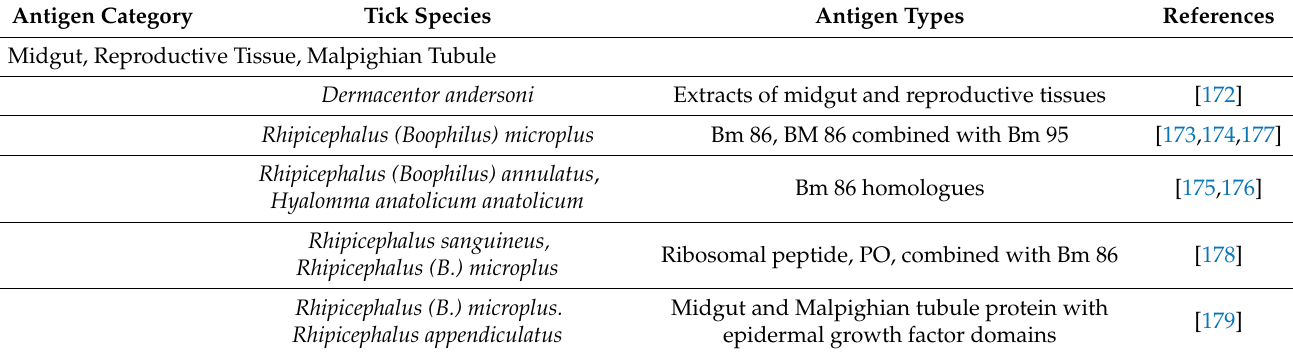
Table 4. Selected examples of anti-tick vaccination antigens